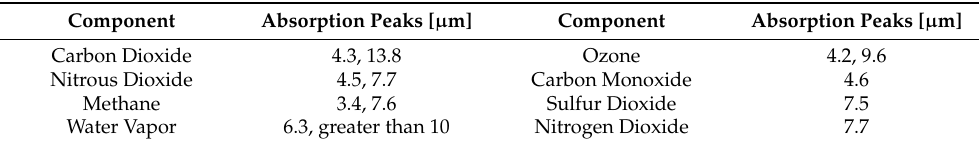
Table 1. Major absorption peaks of gases tracked by NOAA Global Monitoring Laboratory (GML) and the US Environmental Protection Agency’s (EPA) Air Quality Monitoring Stations